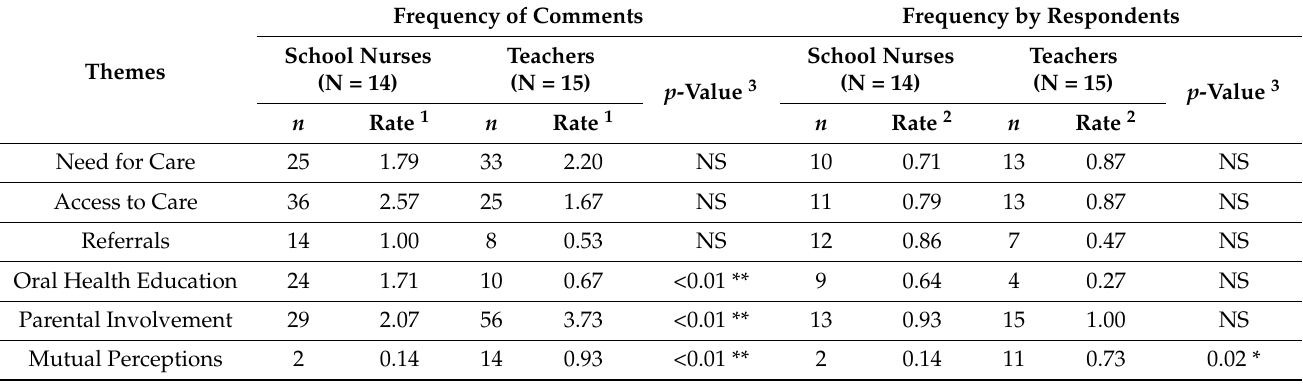
Table 2. Frequency of mentions, by teacher and nurse respondents, for the key themes.